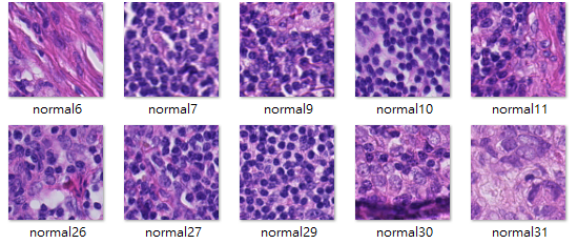
Figure 8. Samples of type A stain images.